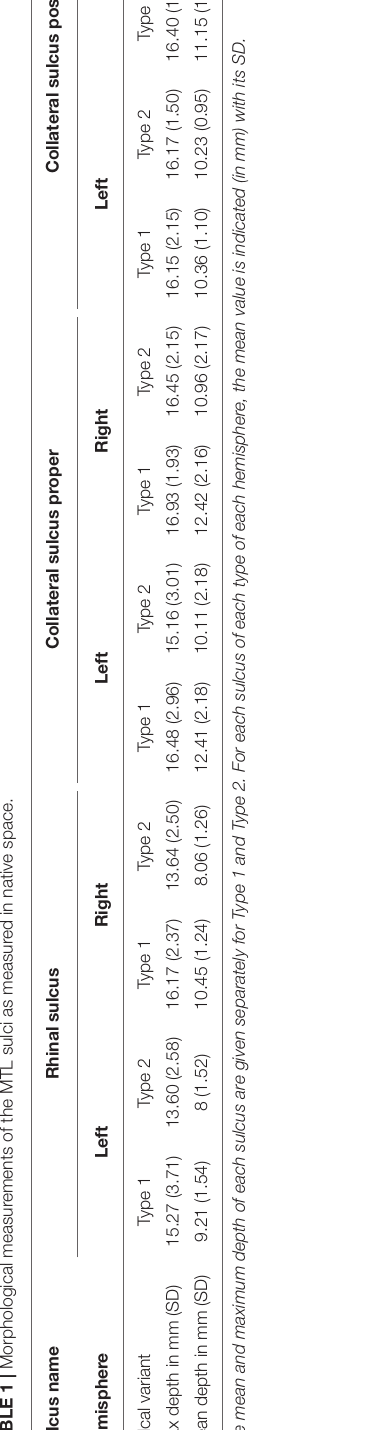
(i.e., Type 1 vs. Type 2) was related to different locations of Type 1 and Type 2 sulci of RS, CS and CS proper sulci in normalized space. The location of each mean sulcus (the sulcus computed over all subjects) was thus defined on each axis (i.e., x, y, and z axes) by pair of extrema, i.e., a minimum and a maximum location for each axis in the x, y, and z directions ( Figure 3 ). Hence, the minima of a sulcus on the x-axis corresponds to the most medial point of the sulcus, while its maxima corresponds to the most lateral point; on the y-axis, the minima corresponds to the most rostral/anterior point, while the minima corresponds to its most caudal/posterior point; and for the z -axis, the maxima corresponds to the most dorsal point, while the minima corresponds to the